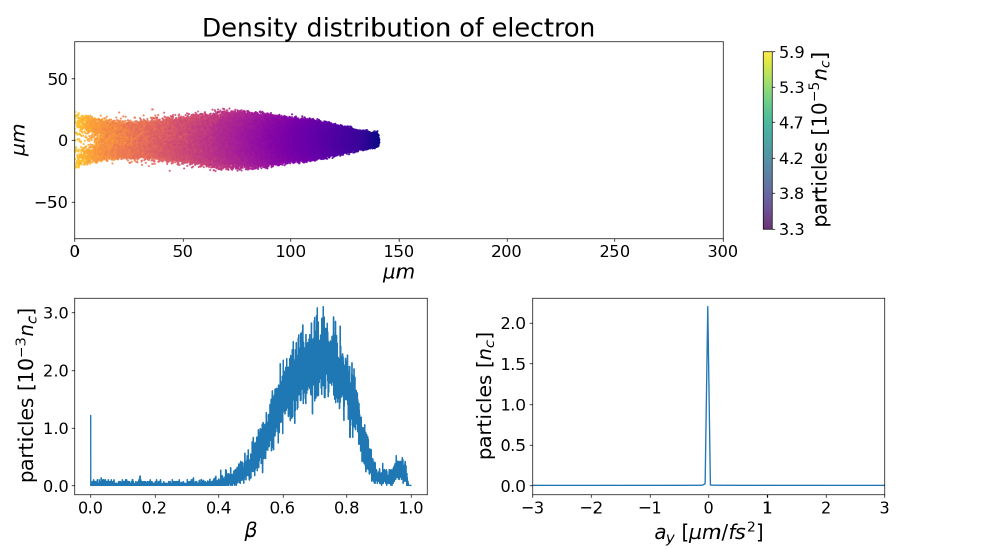
Figure 25. Backward accelerated electrons. The top figure is the electron density distribution shown by color. The bottom left figure is the velocity distribution in β = v / c , where v is the velocity of the electron and c is the speed of light. bottom right of the figure shows the acceleration of the electron on the y